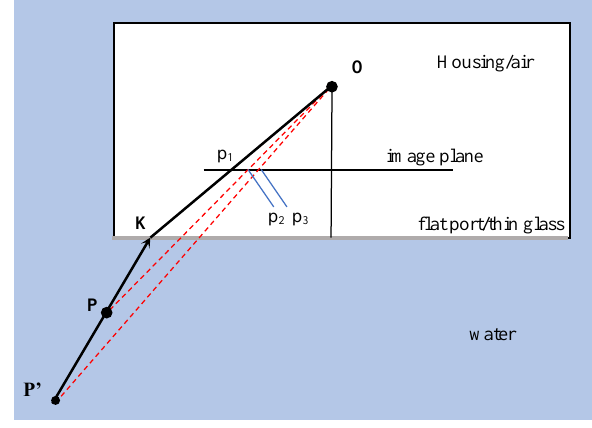
Figure 2. Refracted light-ray path and invalidity of Single View